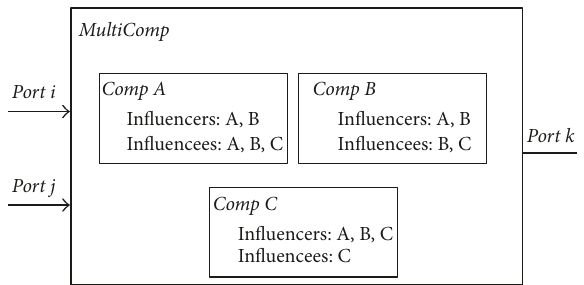
Figure 1: A multiDEVS model: components can interact through state transition